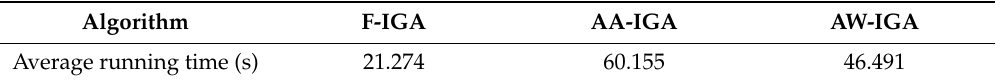
Table 2. The average running time of the three